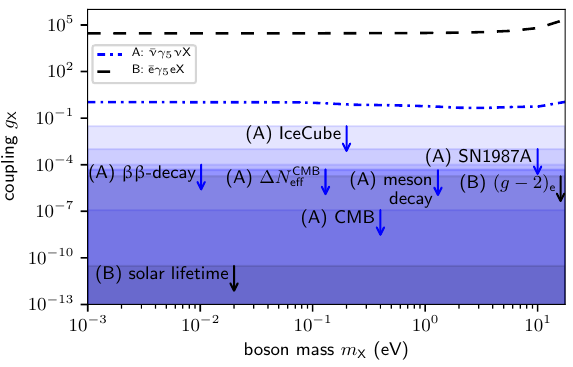
Figure 7 . Statistical sensitivity contours for eV-scale light pseudoscalar bosons. Shown is the 90 % C.L. statistical sensitivity of Katrin for the detection of eV-scale light pseudoscalar bosons. The types A, B are defined according to table 1. Furthermore, the shaded areas mark the parameter regions allowed from constraints discussed in section